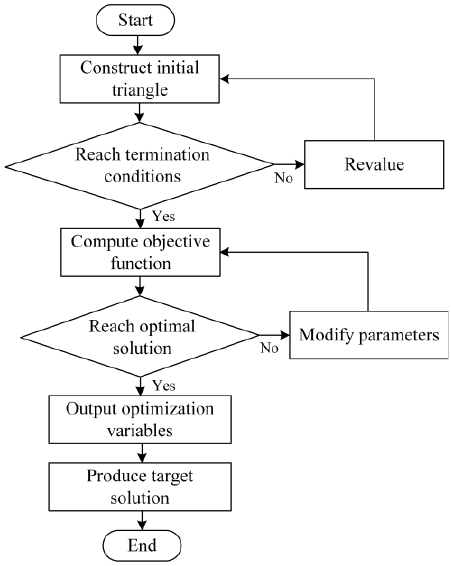
Figure 8. Workflow of N-M optimization algorithm.